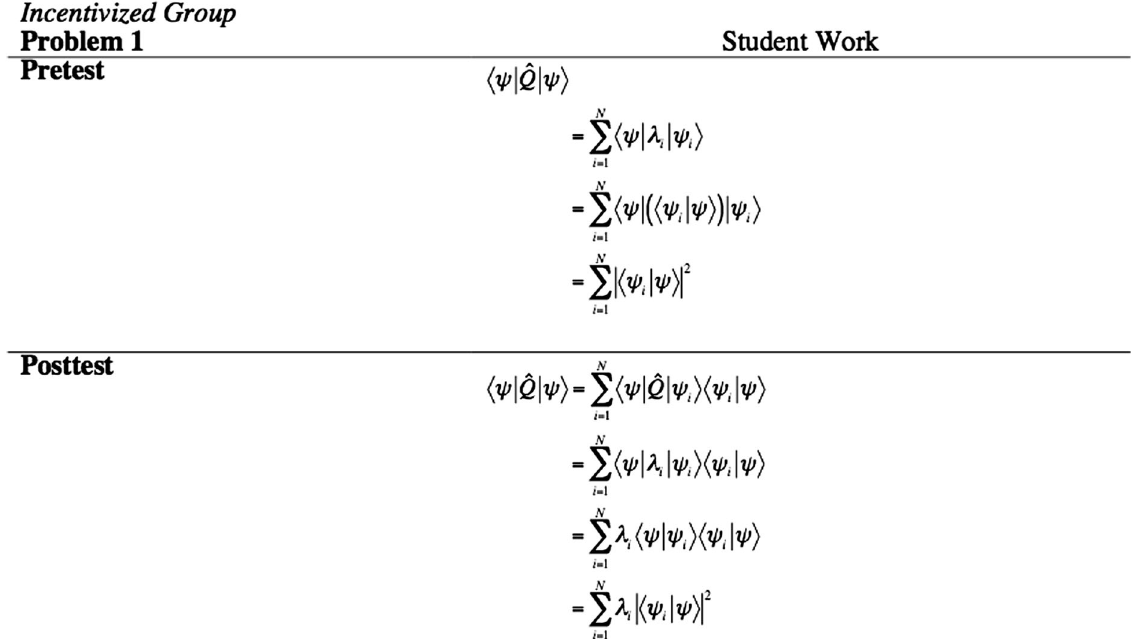
FIG. 7. An example of a pretest and posttest solution pair for a student from the incentivized group, which demonstrates improvement in student understanding for the expectation value problem. The pretest and posttest scores are 54% and 100% for invoking, 33% and 100% for applying, and 44% and 100% for the overall scores, respectively. While the pretest solution shows difficulty with the ˆ ˆ Q and confusion between the eigenvalue of Q and the probability expansion of a general state in terms of the eigenstates of the operator amplitude for measuring Q , the posttest shows excellent use of Dirac notation to solve the